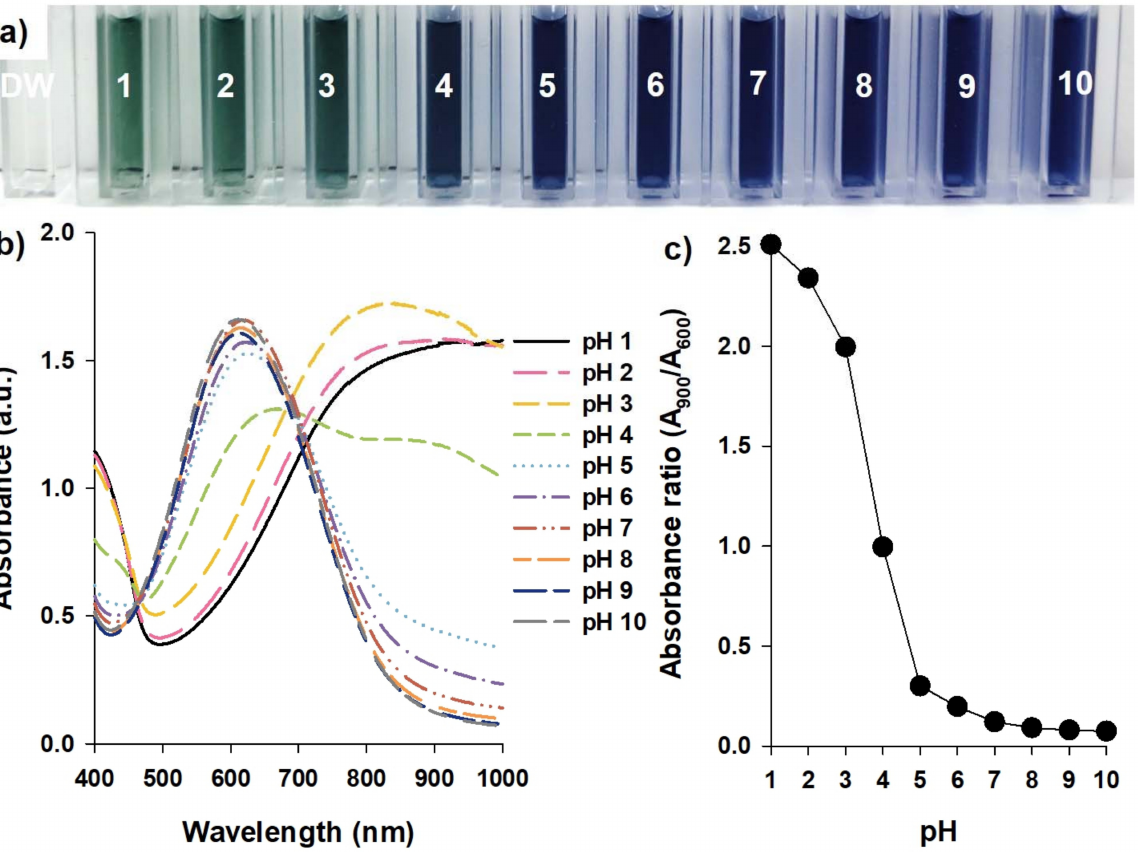
Figure 2. ( a ) Photograph, ( b ) absorbance spectra, and ( c ) absorbance ratio of the TPAni nanoparticles in varying surrounding